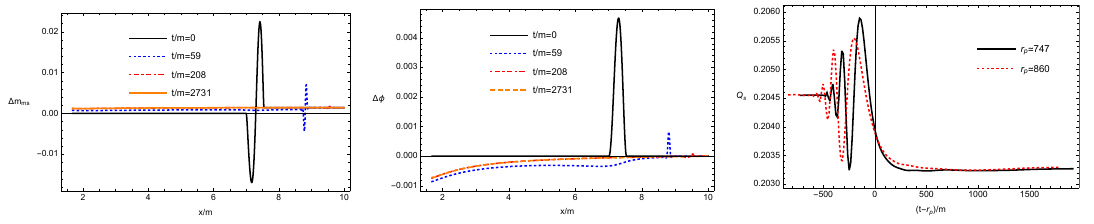
Figure 8 . Left: the deviation of the MS mass as functions of x/m , evaluated at different time instants. Middle: the deviation of the scalar field as functions of x/m , evaluated at different time instants. The deviations are evaluated with respect to their values of the initially static HBH. Right: the scalar charge as a function of ( t r p ) /m , evaluated at given radial coordinates r p = 747 and −